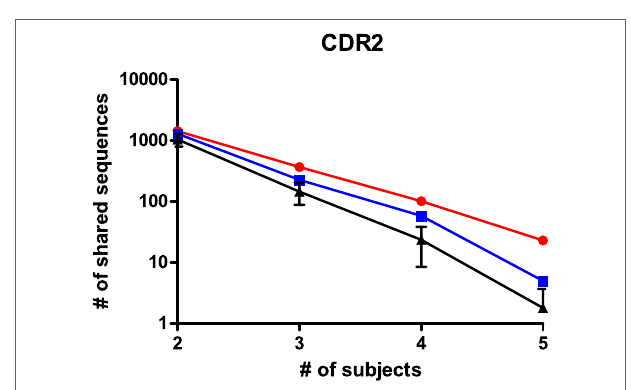
FigUre 4 | The number of shared peptides that were observed for CDR2 sequences in the NGS dataset. Peptides that were shared among animals, but still unique to one of the antigens were enumerated and shown as a function of the number of subjects among whom they were shared, for HuD immunized animals (Red), DNP-immunized animals (Blue) and randomized groups of mixed composition (black, average ± SD, n = 10). A similar analysis for other regions in the immunoglobulin molecule is presented in Figure S4 in Supplementary Material.